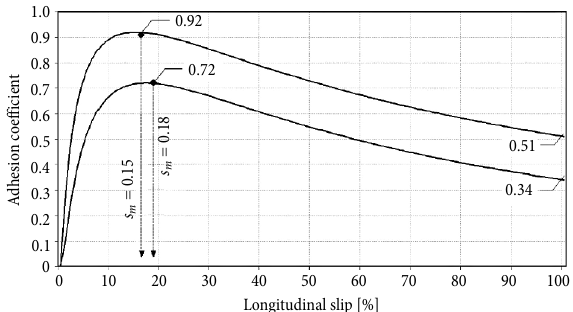
Fig. 13. Characteristics m = f ( s ) drawn according to actual measurement values m max/ m 100% and s m for points ‘*’ (stretches X1 and X2, see Table 3)